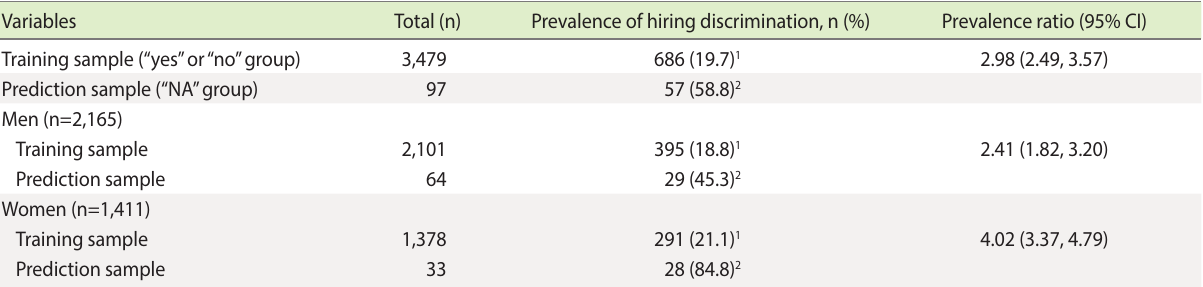
Table 2. Gender differences in under-reporting hiring discrimination based on the random forest prediction